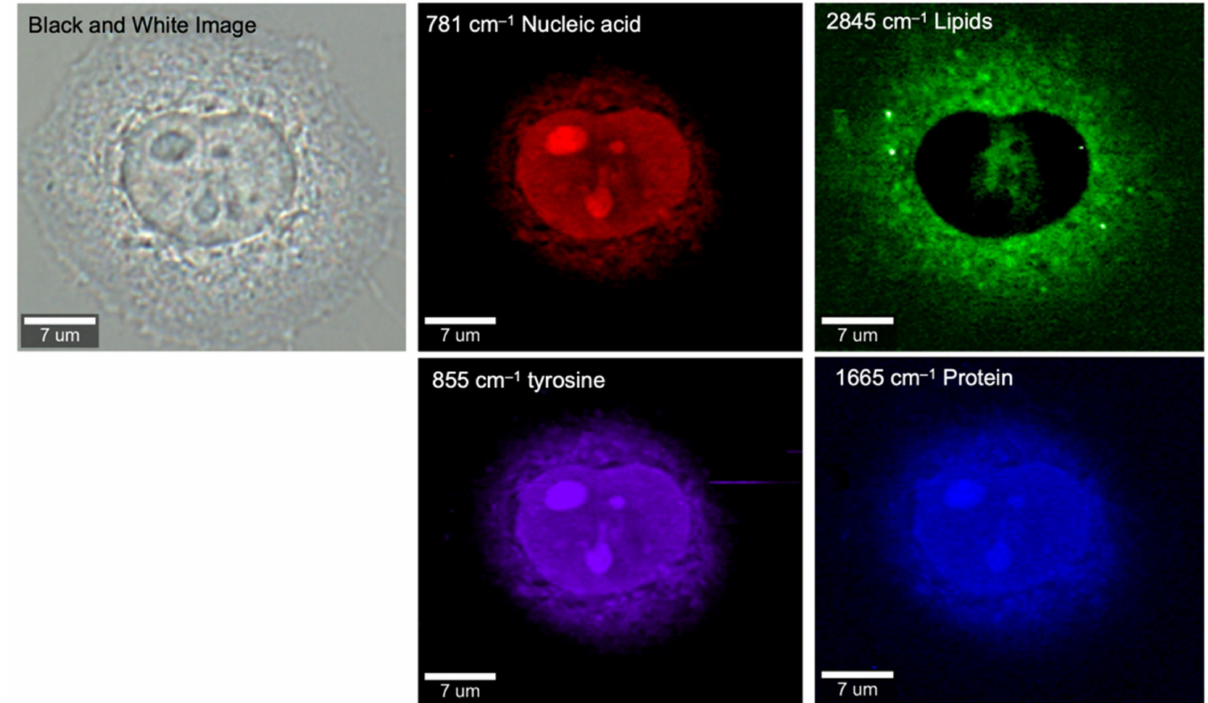
Figure 4. Raman images of a HeLa cell based on fingerprint Raman spectra, reconstructed from intensities at 781 (nucleic acids), 855 (tyrosine), 1665 (protein), and 2845 cm − 1 (lipids). The Raman images show the distributions of these biomolecules with various intensities at the subcellular